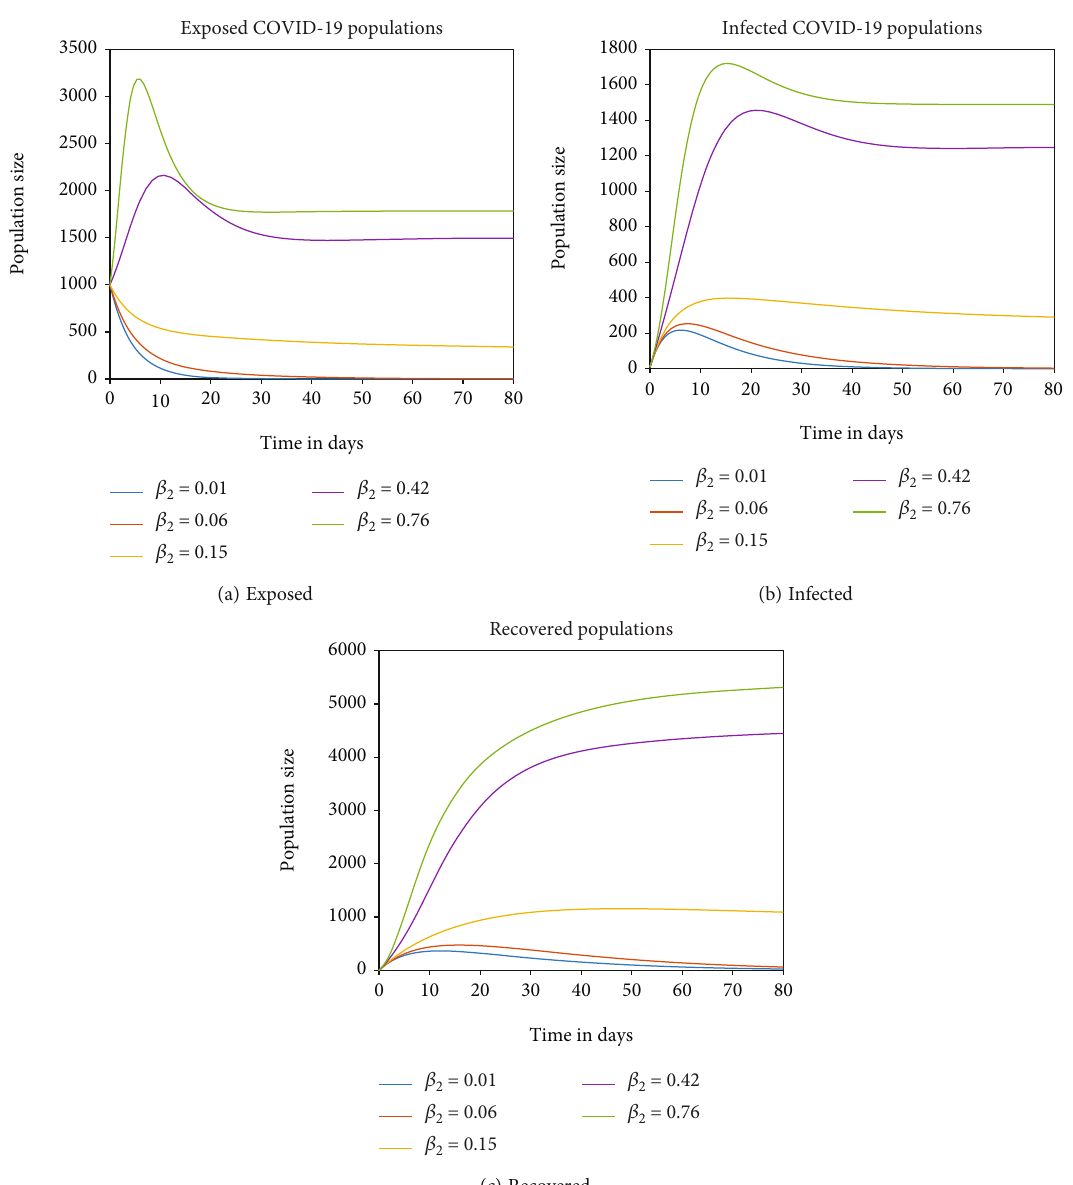
2 ) for the COVID-19 only